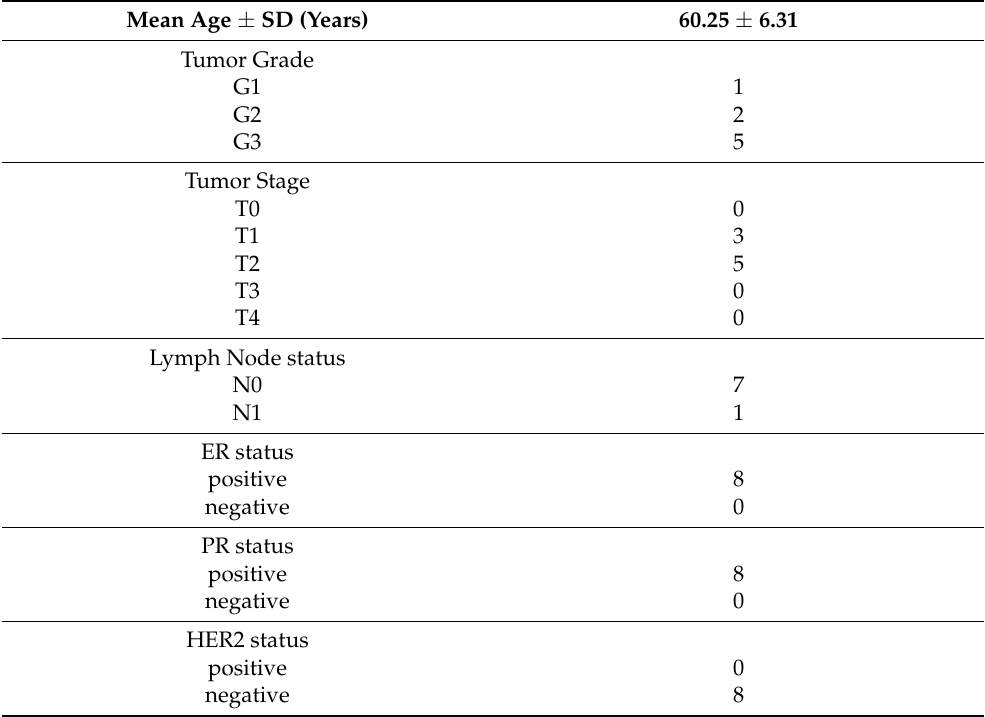
Table 1. Clinico-pathological parameters of patients (n = 8) with invasive BCs used for BCAF isolation. Mean Age ± SD